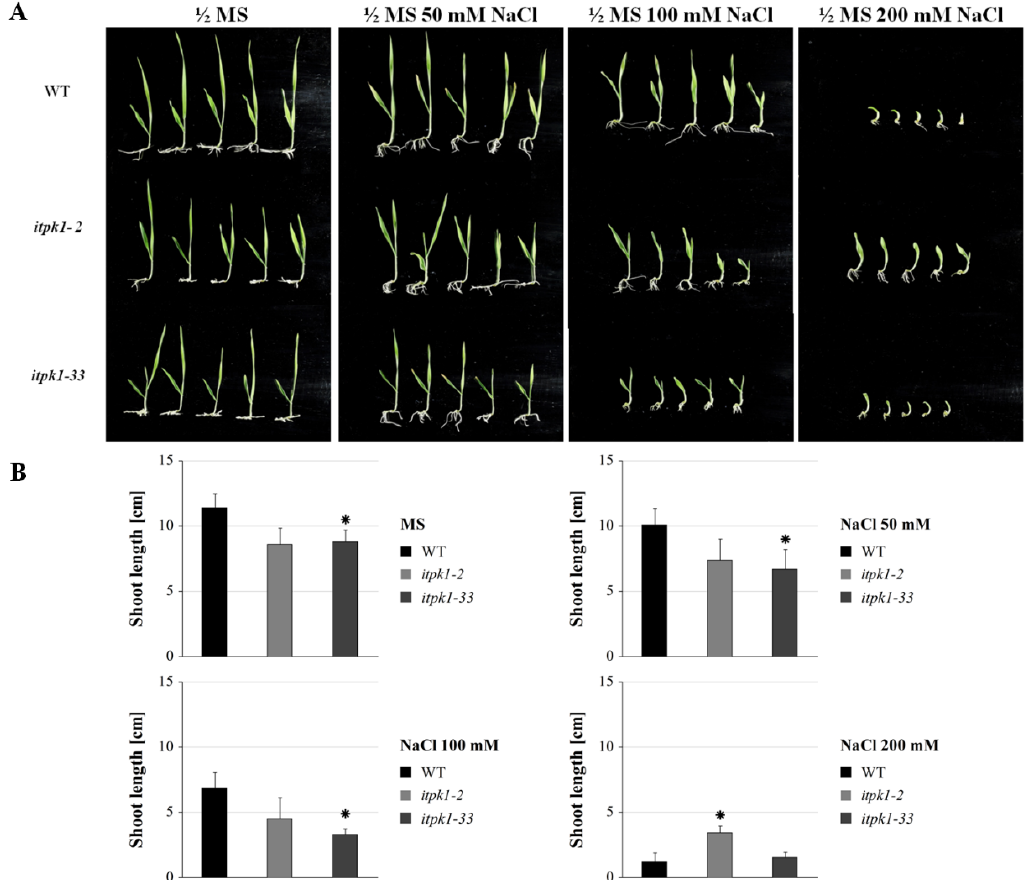
Figure 5. The effect of NaCl on in vitro cultivated barley itpk1 mutants. ( A ) Barley seedlings from itpk1-2 , itpk1-33 and WT groups under control and increasing salt concentration conditions. ( B ) Shoot length after 10-day in vitro cultivation at control and salt stress conditions. The values are the means ± SD (n = 5). The asterisks represent significant di ff erences in the shoot length at p < 0.005 compared to WT based on the